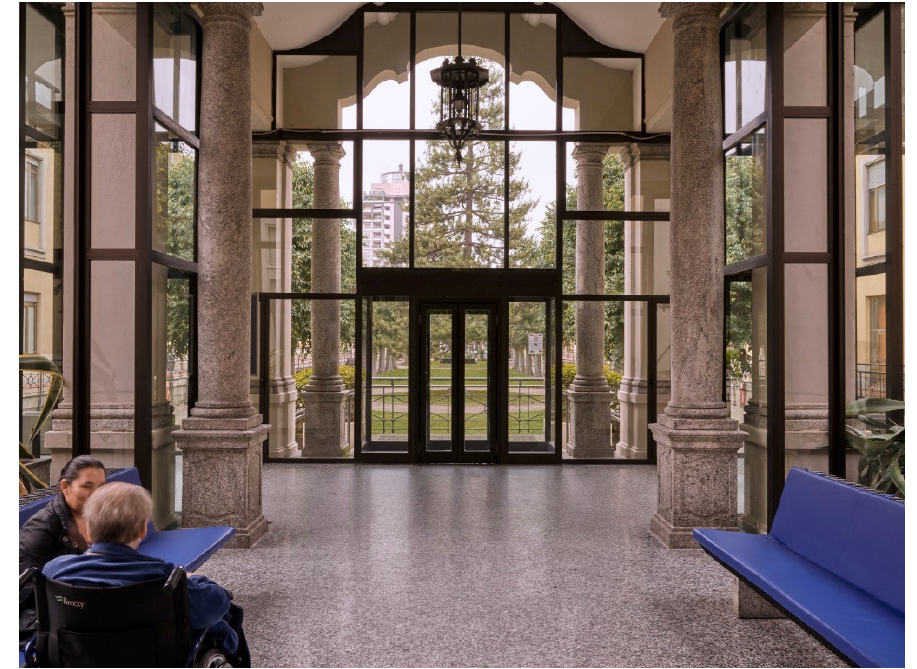
Figure 5. The entrance hall of WeMi Trivulzio. Source: Courtesy of Giovanni Hänninen. street. Besides the orientation desks, the space is avail‐